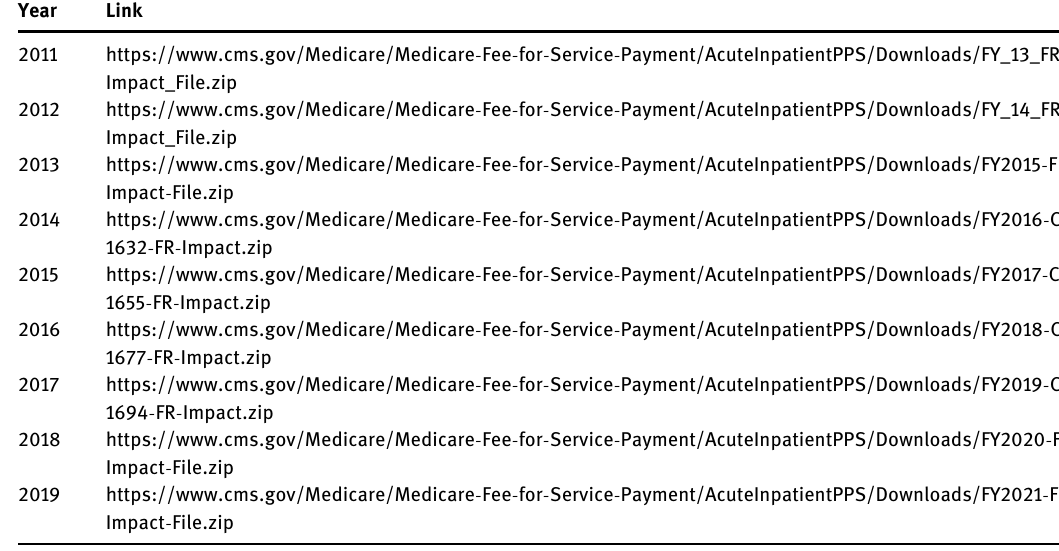
Table A5: Download links for the Impact Files